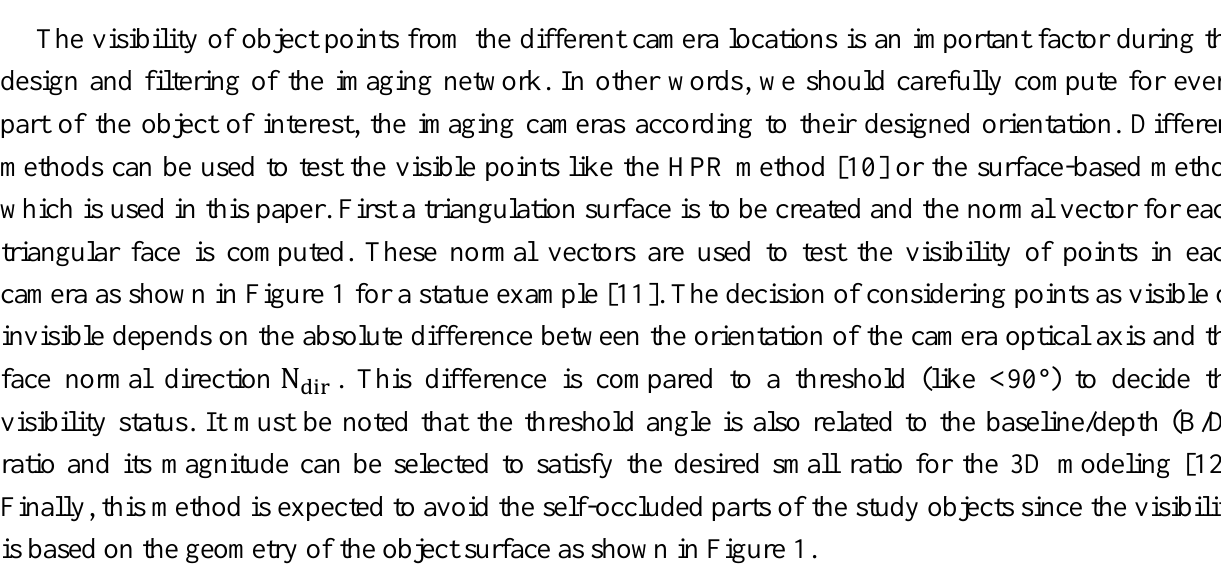
Figure 1. Visibility by using the triangular surface normal